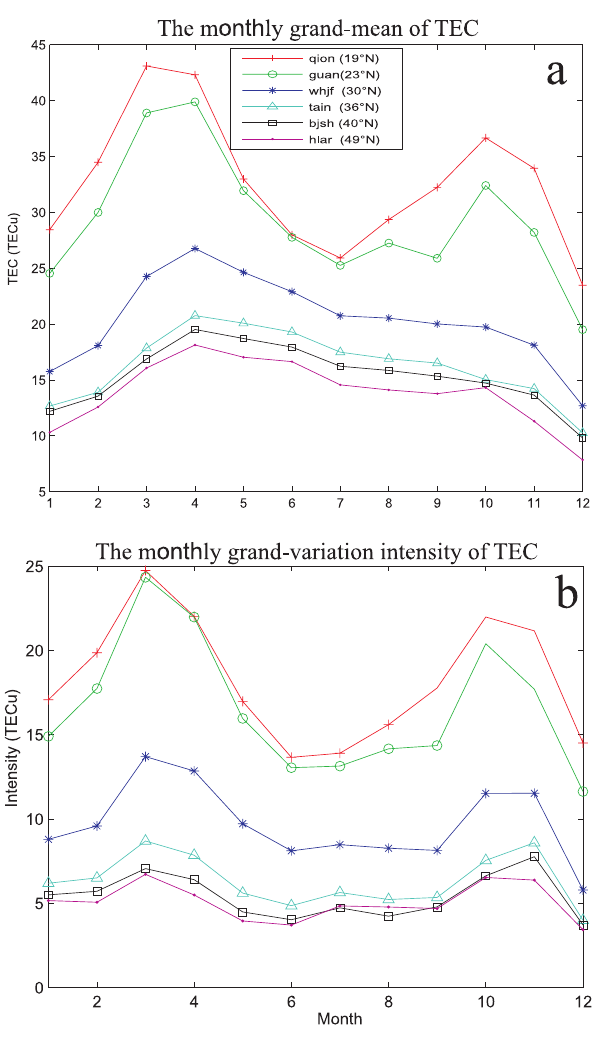
Fig. 6. Seasonal variations of the monthly grand-mean (a) and the monthly grand-variation intensity (b) of TEC at six GPS sites along 120 ◦ E.